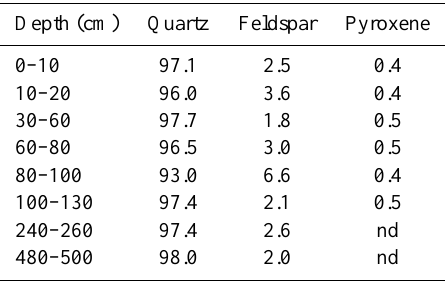
Table 1. Mineralogical composition (wt.-%) of soil horizons and sediment layers by semiquantative X-ray